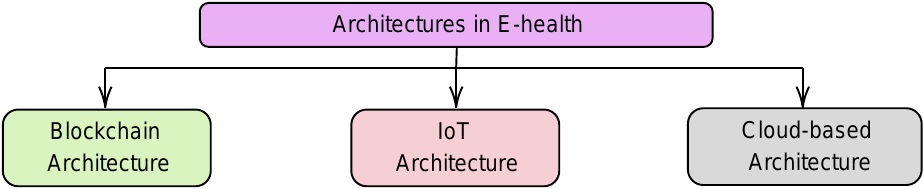
Figure 5. Different architectures for deploying